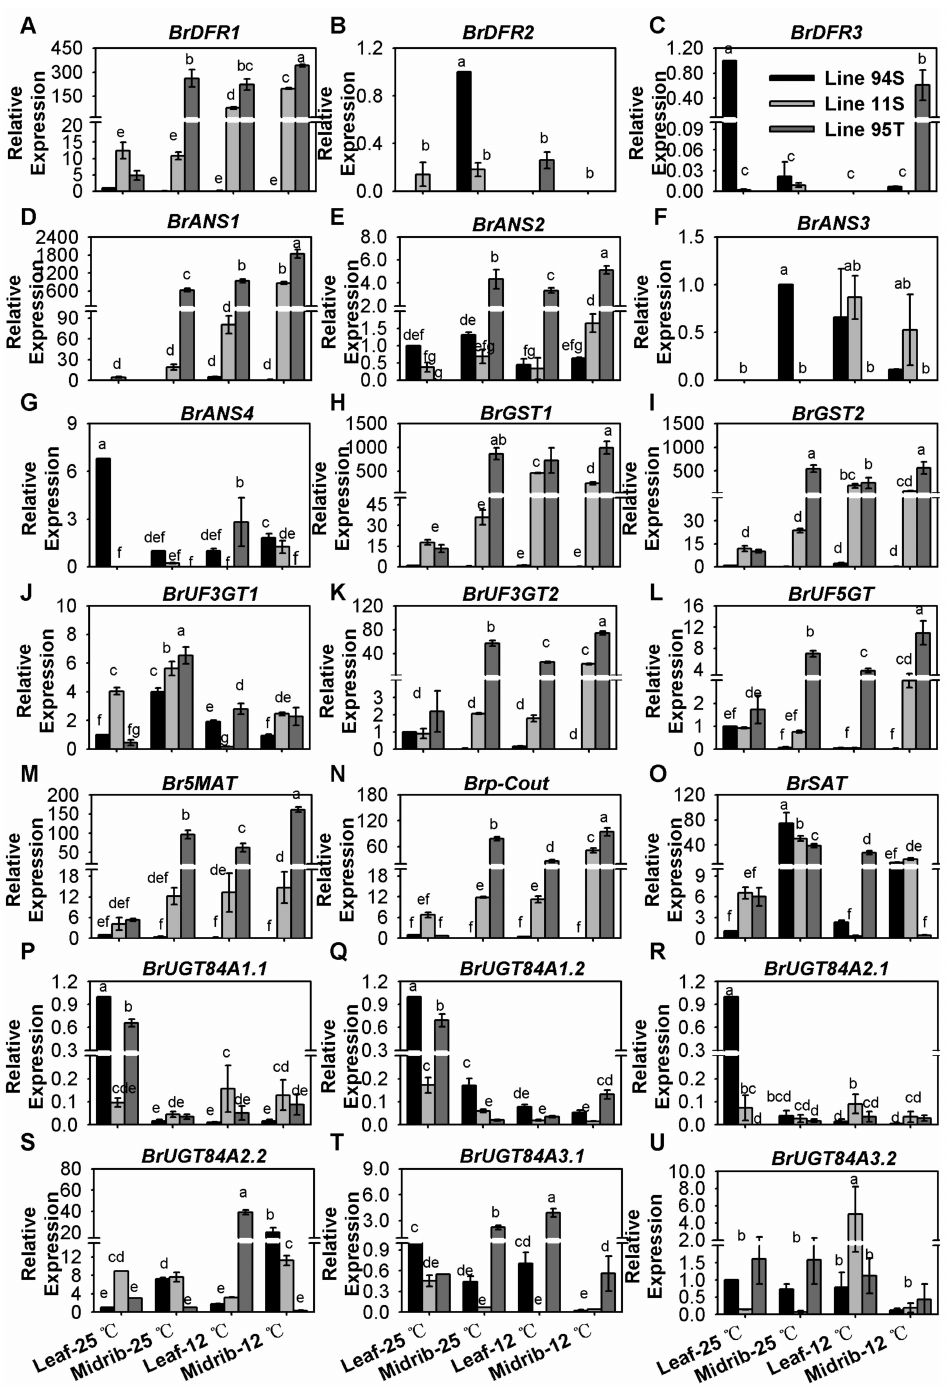
Figure 4. Expression of late biosynthesis genes (LBGs) and transport BrGSTs in the seedlings of three Chinese cabbages under low temperature treatment. ( A – C ) relative expression of BrDFRs ; ( D – G ) relative expression of BrANSs ; ( H , I ) relative expression of BrGSTs ; ( J – L ) relative expression of BrUGTs ; ( M – O ) relative expression of BrATs ; ( P – U ) relative expression of BrUGT84As . Plants of three lines were grown under a 12-h light photoperiod at 25 ◦ C, 125 mmol m − 2 s − 1 ; 28-day seedlings were treated at 12 ◦ C for 15 days, and the seedlings that stayed at 25 ◦ C with same light condition were treated as the control. Seedling leaves were divided into the midribs and the leaves, and leaves of Line94S at 25 ◦ C served as the control. Values are presented as means ± SD ( n = 3). The di ff erent letters above each column are significantly di ff erent at p < 0.05 by Duncan’s